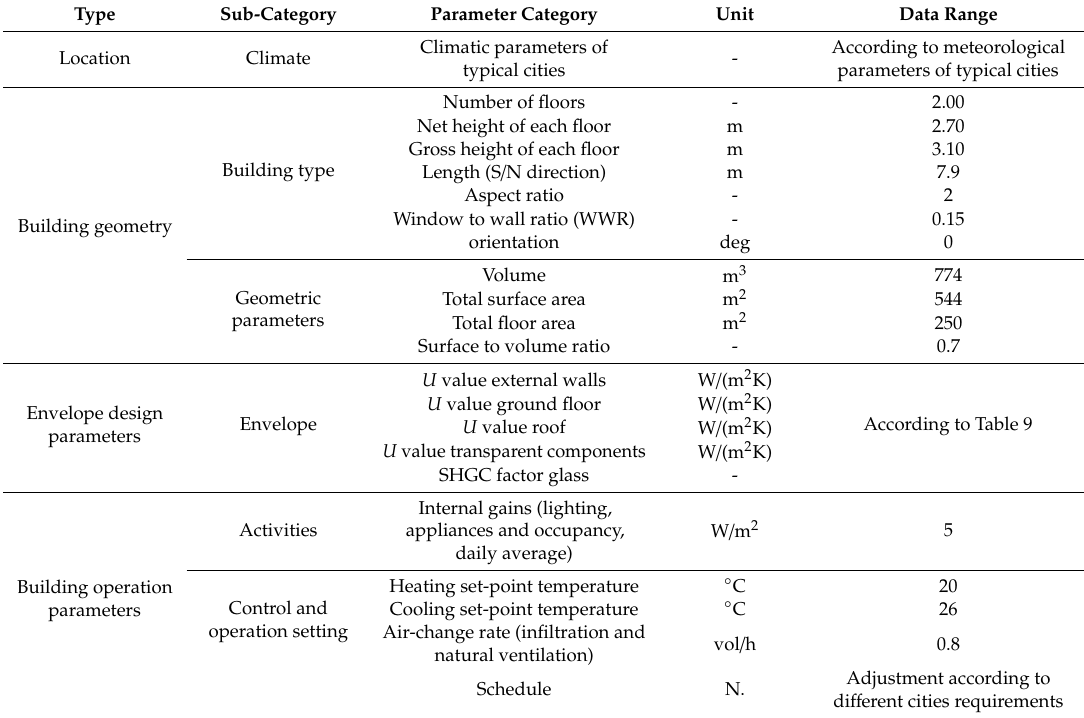
Table 3. Parameters of typical